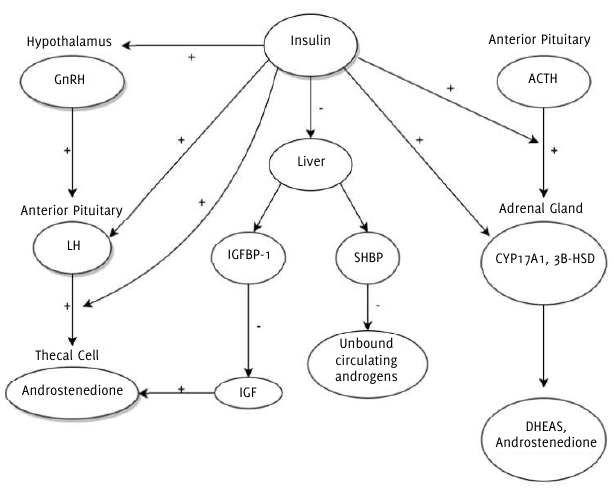
Figure 1 . Proposed mechanisms of insulin regulation of androgen synthesis and circulatory levels.